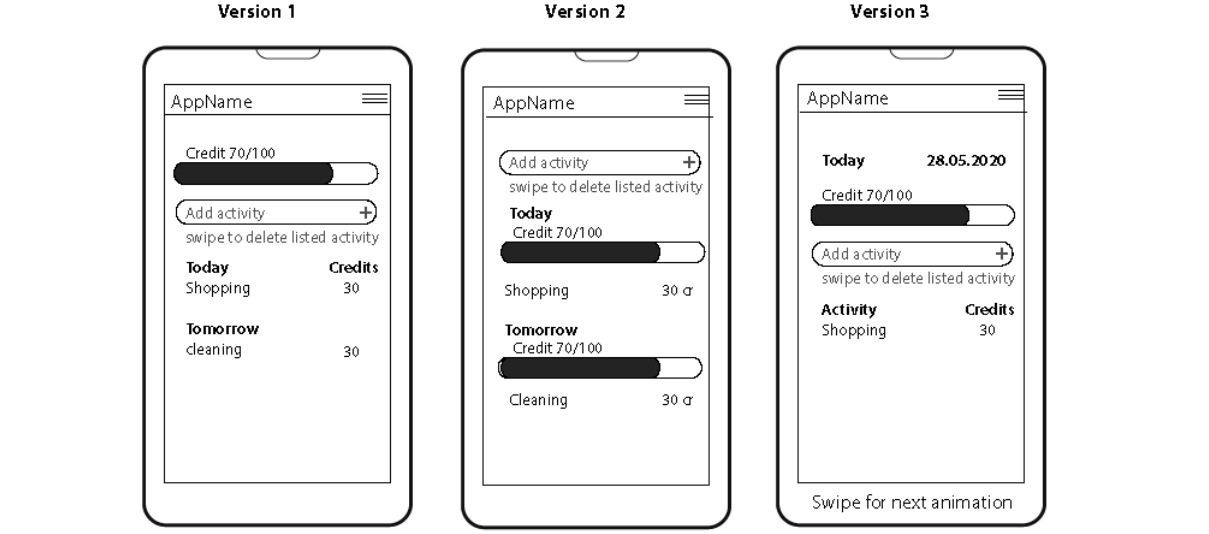
Figure 2. Successive iterations on main screen